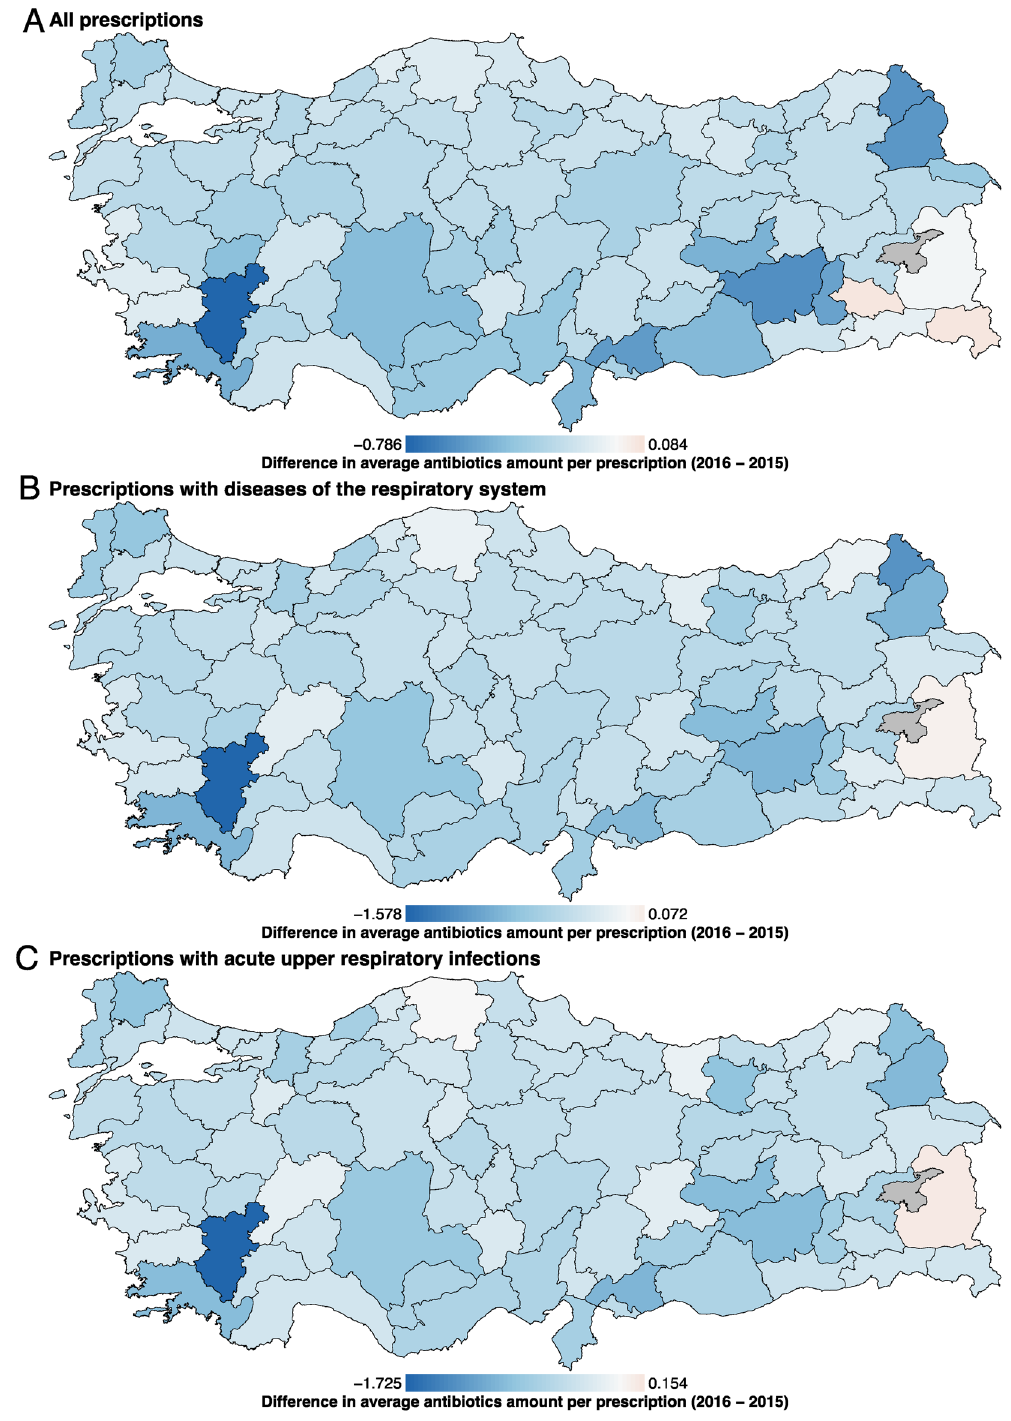
Figure 1. Average antibiotics amount per prescription for each province. ( A ) Over all prescriptions, ( B ) Over prescriptions with “diseases of the respiratory system” (i.e., ICD10 chapter J00-J99), and ( C ) Over prescriptions with “acute upper respiratory infections” (i.e., ICD10 block